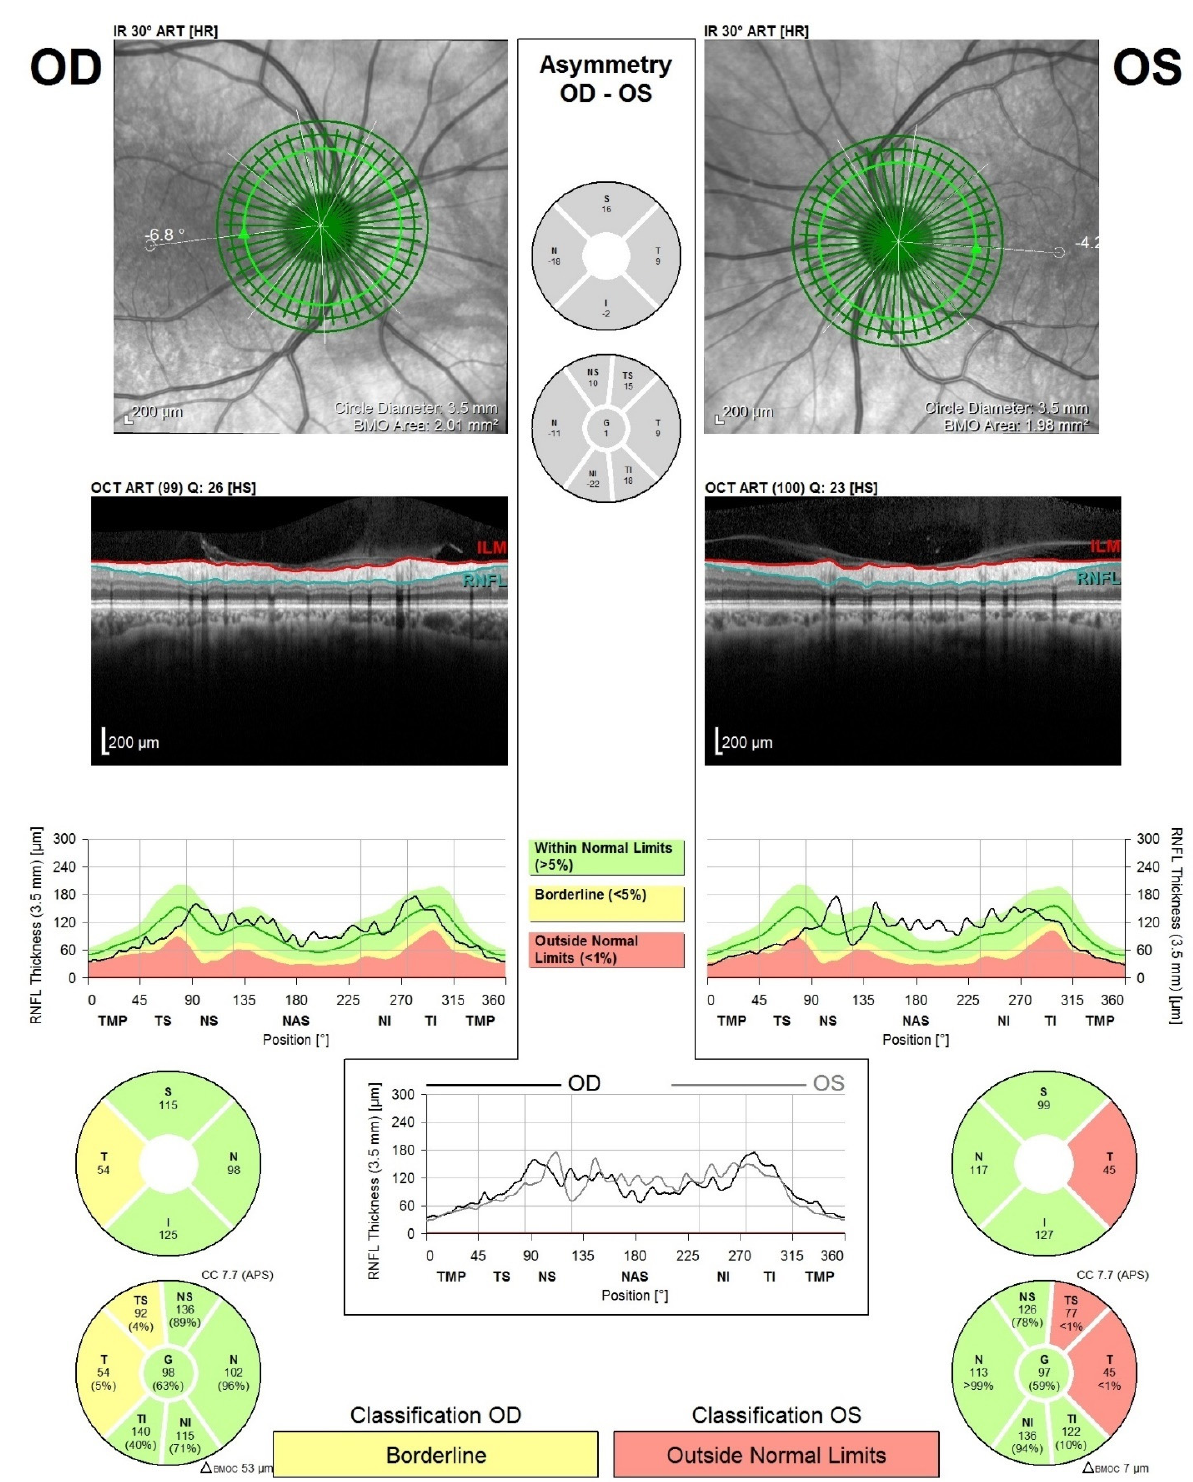
Figure 1. Heidelberg Spectralis OCT acquisition of a cpRNFL scan in a PD patient. The cpRNFL scan was divided into six retinal sectors: temporal, temporal-superior (TS), nasal-superior (NS), nasal (N), nasal-inferior (NI), and temporal-inferior (TI). OD-oculus dexter; OS-oculus sinister. In this particular case, the cpRNFL of the left eye was affected in the temporal and temporal-superior sectors.